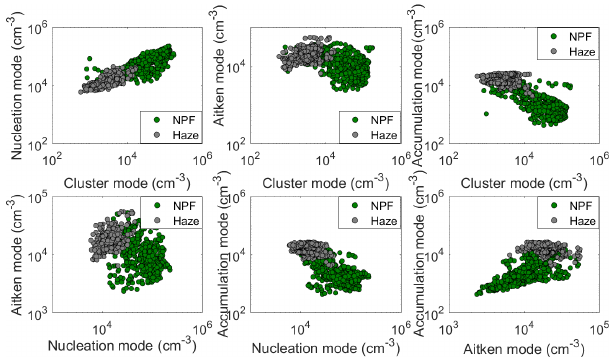
Figure 12. Correlation between different particle modes on the NPF event days (green dots) and the haze days (gray dots). The time resolution of data in the plots of correlation between cluster mode and other modes was 12min, and the time resolution of other data points was 5min.